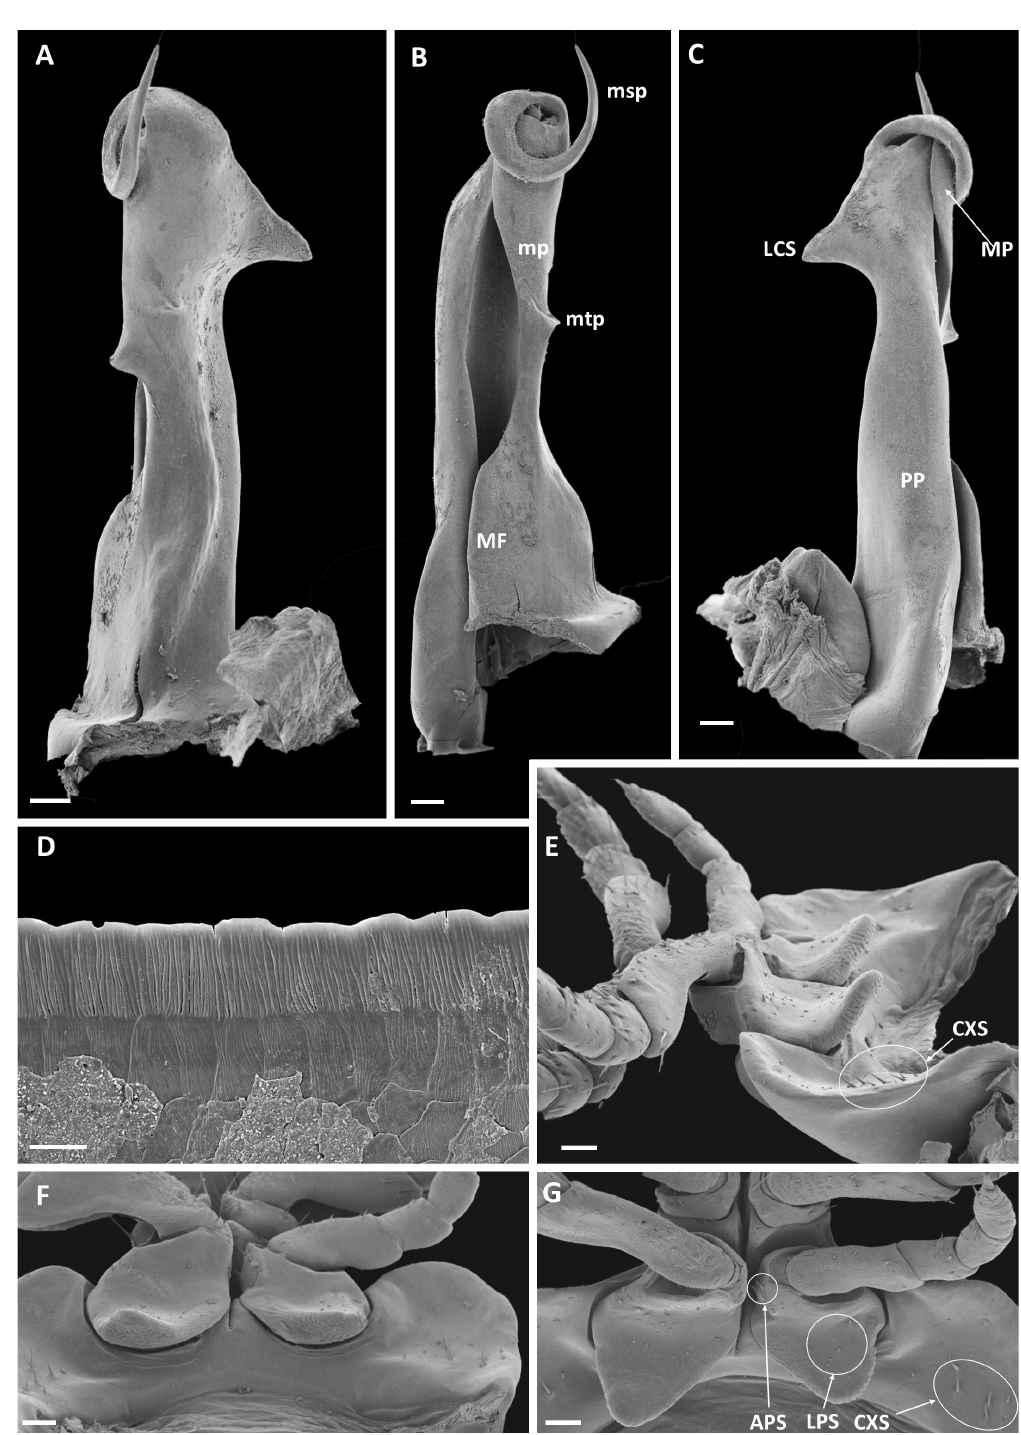
Fig. 52. Raduliverpa donatellae sp. nov. A–C . Holotype, ♂ (NHMD 621759). Left gonopod coxa. A. posterior view. B. Mesal view. C. Anterior view. D . Midbody dorsal limbus. E–G . Paratype, ♂ (NHMD 621760), first and second pair of legs (right first legs misshapen/diminished). E. Sublateral view. F. Anterior view. G. Ventral view. Abbreviations: APS = mesapical prefemoral setae; CXS = coxosternal setae; LCS = lateral coxal process; LPS = lateral prefemoral setae; MF = metaplical flange; MP = metaplica; msp = metaplical spinelike process; mtp = metaplical triangular process; PP = proplica. Scale bars: A–C, E–G = 0.1 mm; D = 0.01